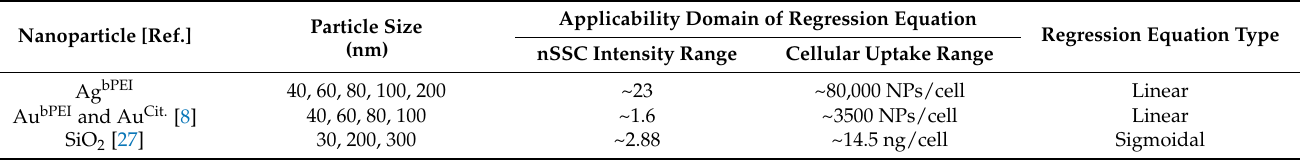
Table 2. Applicability domain of regression equation correlating nSSC from flow cytometry with cellular uptake of three different